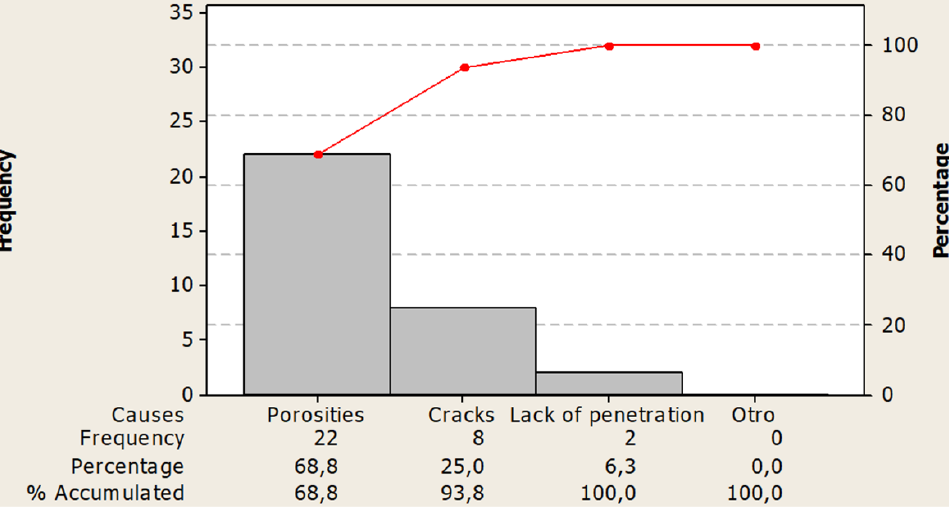
Figure 3. Pareto Diagram - Structure Assembly process Table 4. Defects of the Structure Lining process